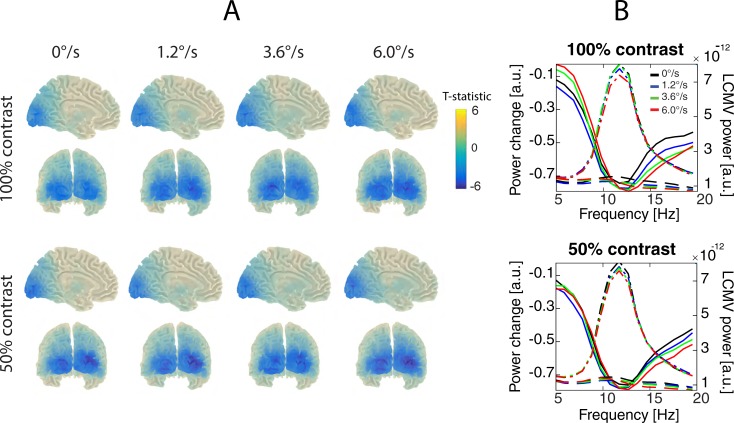
Grand average power changes in the alpha-beta range.A. Statistical maps of the stimulation-related changes in the two luminance contrasts and four motion velocity conditions. Blue color corresponds to suppression of alpha-beta power. B. Spectral changes at a selection of ‘maximally suppressed’ voxels. Dashed lines show absolute power spectra (right y-axis, arbitrary units) corresponding to the periods of visual stimulation. The dot -dashed lines of the same colors show the power spectra for the respective pre-stimulus intervals (also right y-axis). Solid lines show respective stimulation-related changes in power ([post-pre]/pre ratio, left y-axis, arbitrary units). Neither contrast nor velocity had significant effects on the magnitude of alpha-beta suppression.